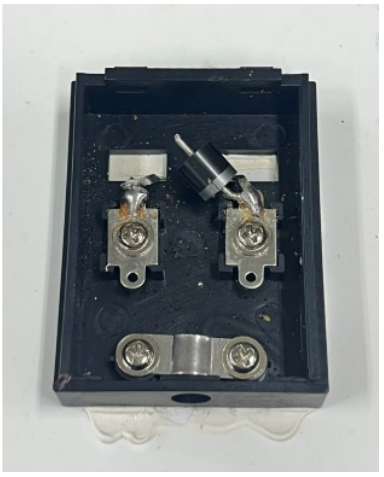
Figure 8. Diode open circuit .